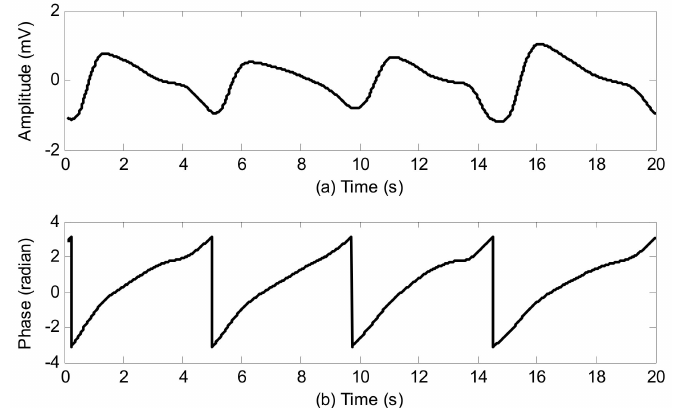
Figure 5. Illustration of respiratory phase calculation. ( a ) Respiratory signal collected from a belt sensor. ( b ) Respiratory phase. Inspiration corresponds to the phase from zero to π and expiration corresponds to the phase from − π to